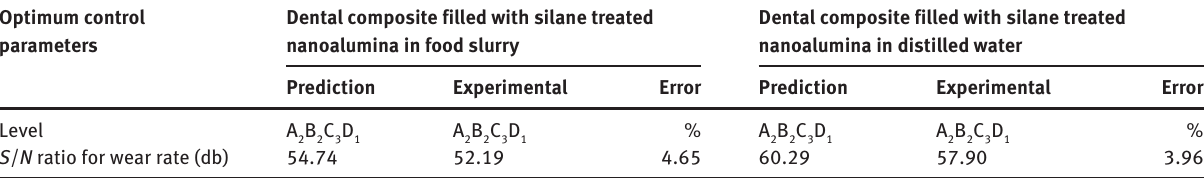
Table 5: Results of the confirmation experiments.